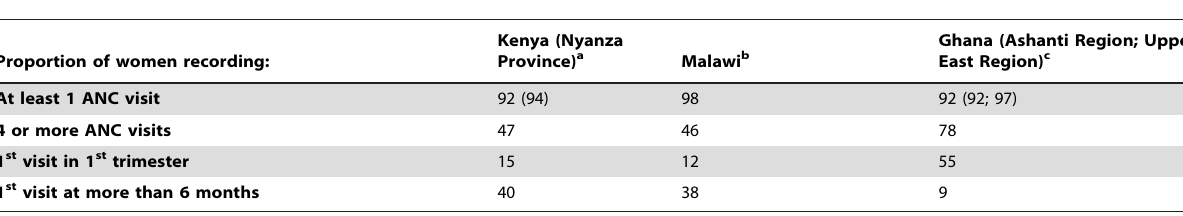
Table 2. National and regional data on ANC attendance.